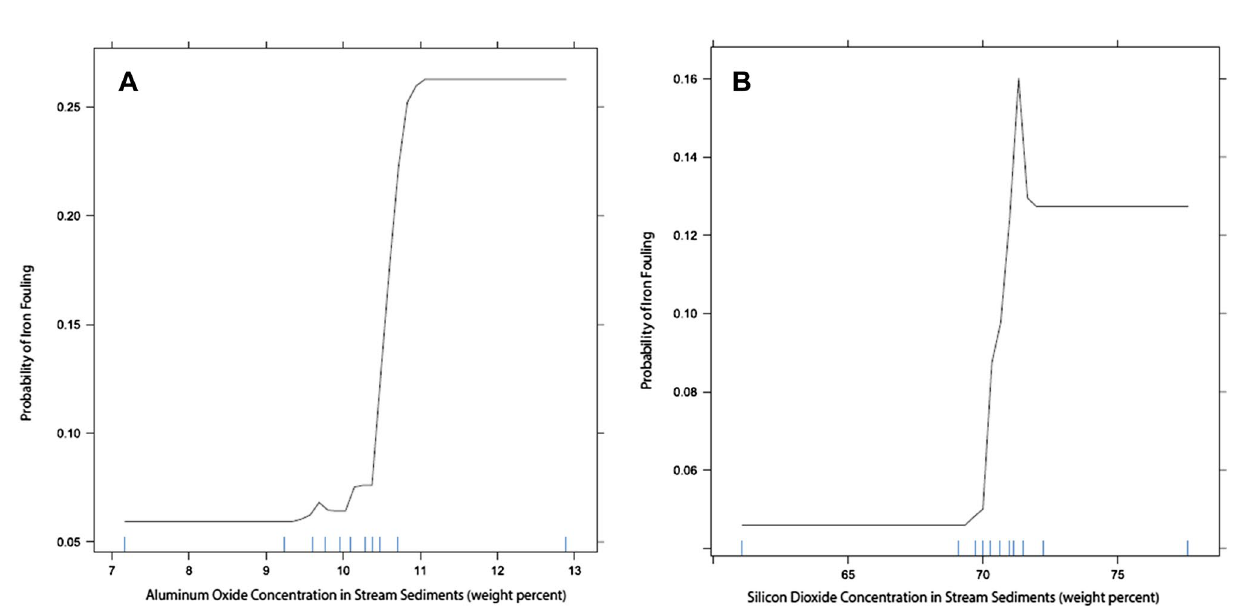
dependence plots for the model are in Supplementary Materials Figures